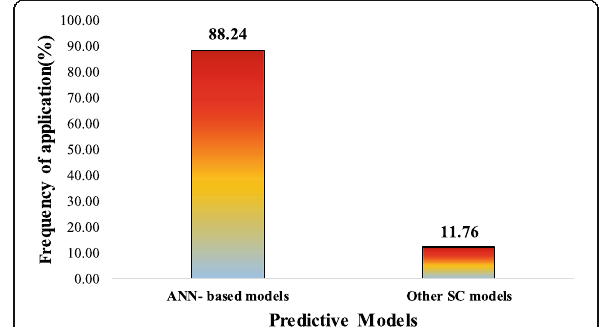
Fig. 4 Frequency of application of the different types of SC model for SST prediction